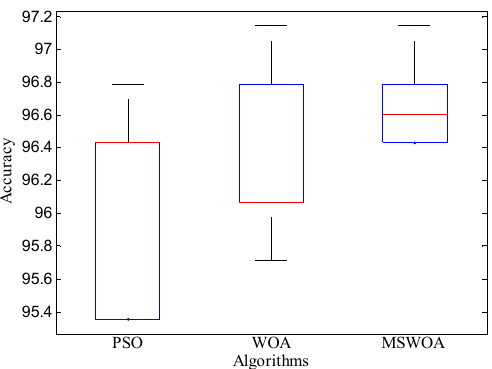
Figure A3. Box plots of fault diagnosis results of four-op-amp biquad high-pass filter circuit.